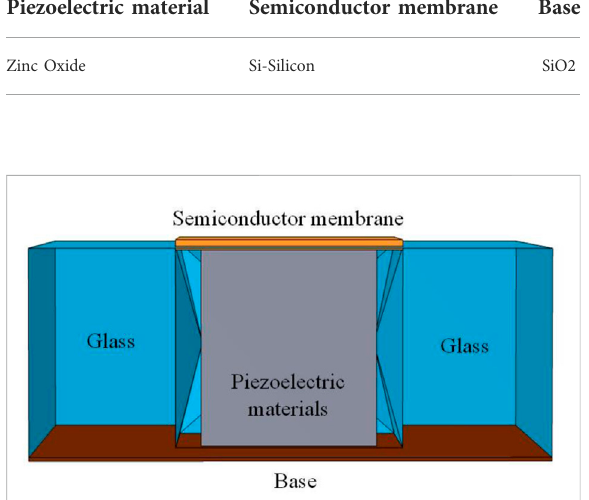
FIGURE 1 Schematic diagram of the sensor interior.